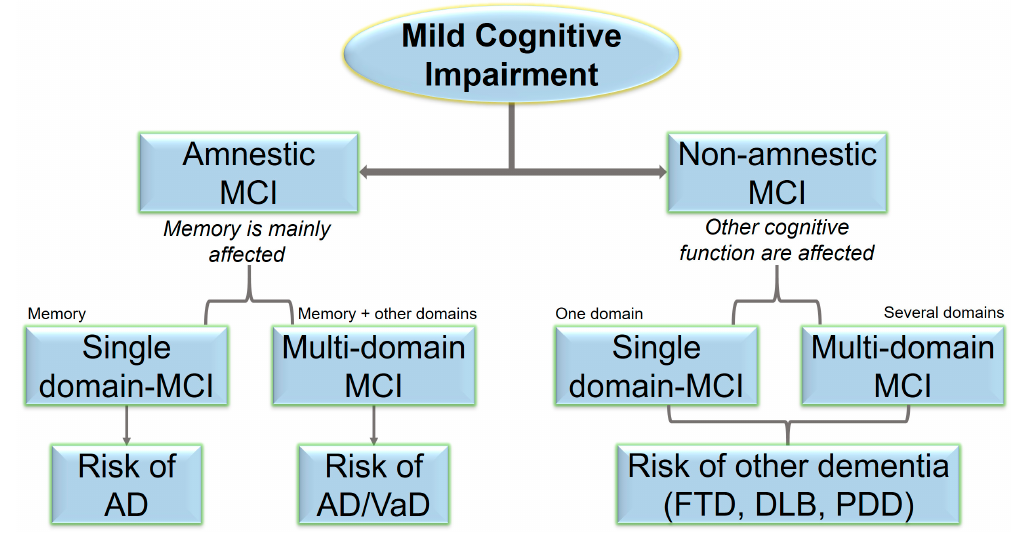
Figure 1. Subtypes of MCI and their risk for neurodegenerative diseases. MCI, mild cognitive impairment; AD, Alzheimer’s disease; VaD, vascular dementia; FTD, frontotemporal dementia; DLB, dementia with Lewy bodies; PDD, dementia in Parkinson’s disease.